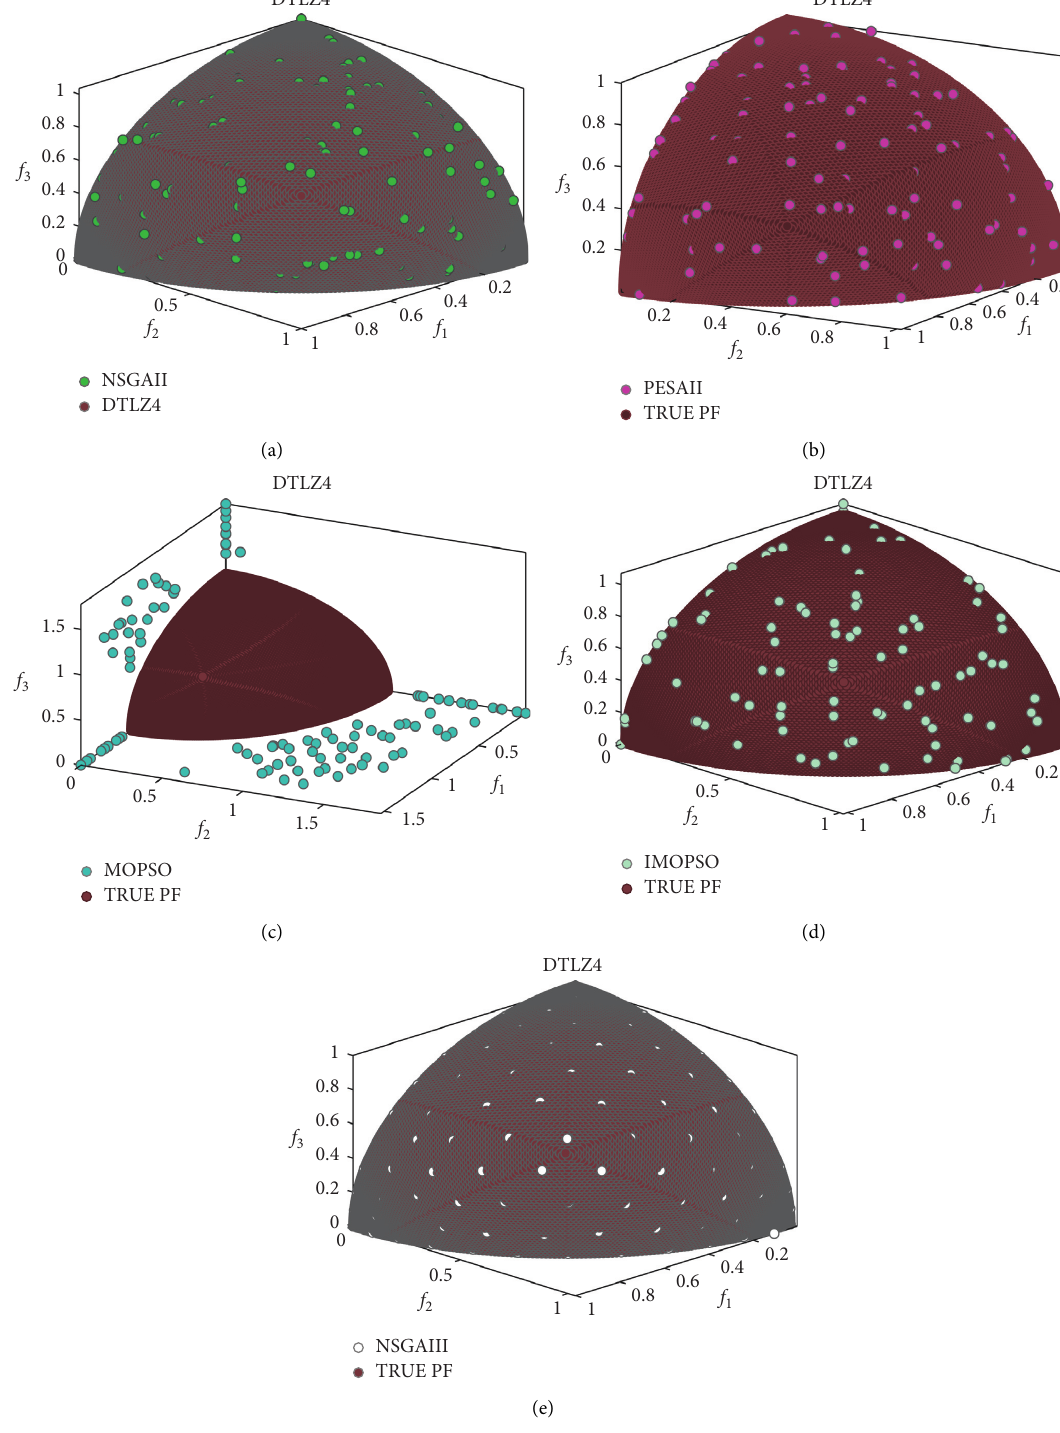
Figure 10: DTLZ4 test